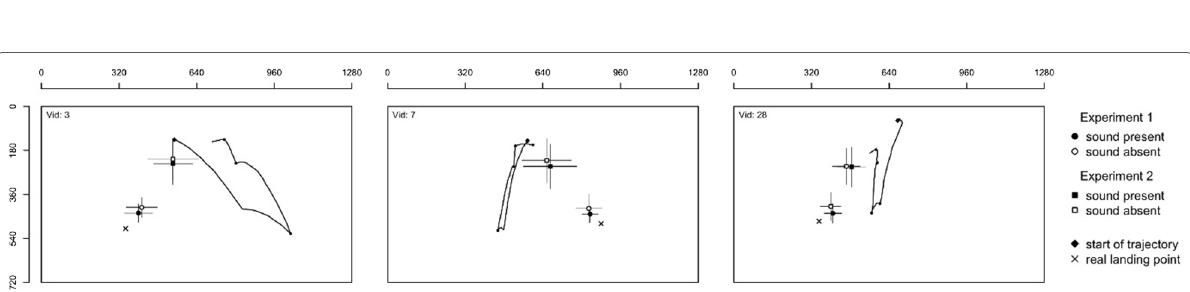
Fig. 4 Examples of presented trajectories including real landing position and estimated landing positions by experiment and sound condition. Whiskers indicate standard deviation of participants’ estimates for the respective